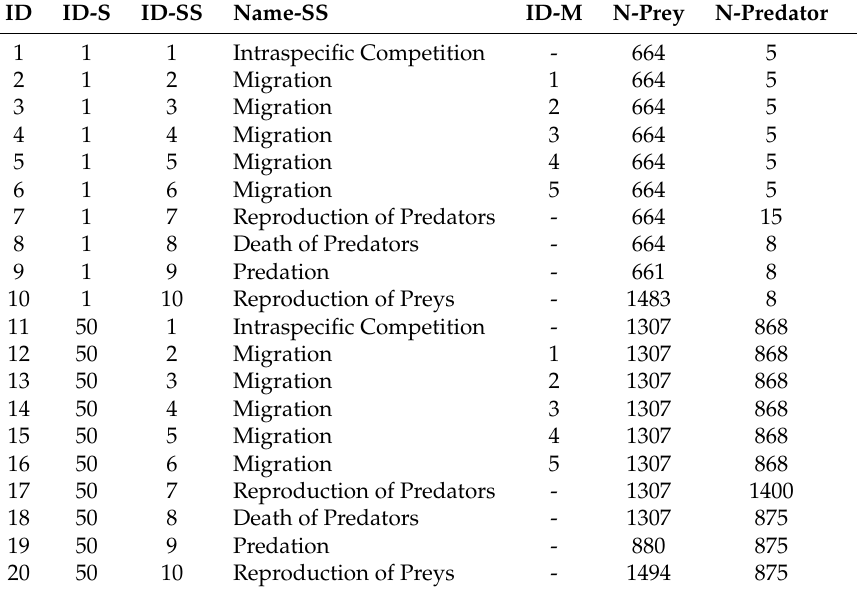
Table 13. Simulation performed using agents—Case